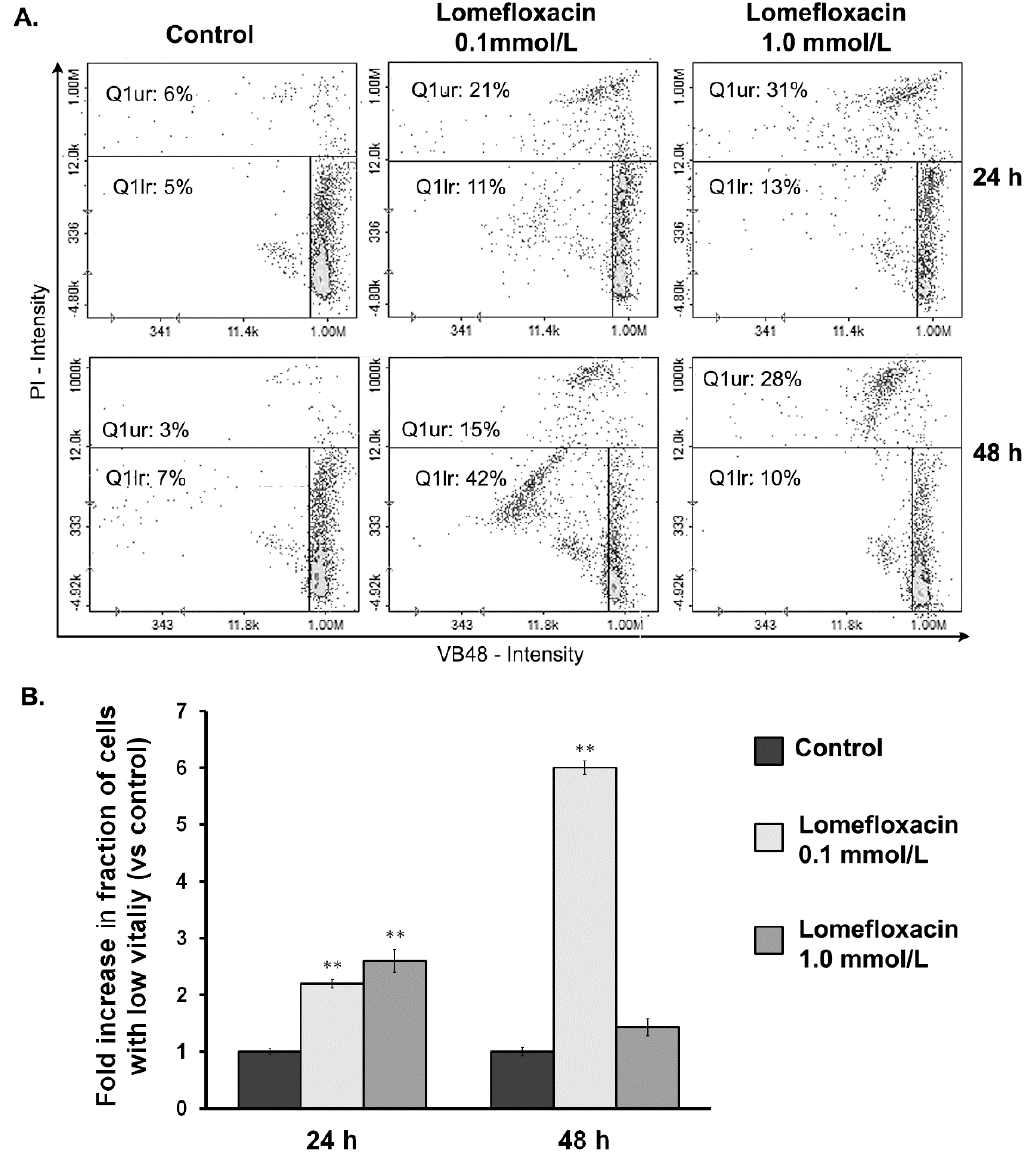
Figure 4. Analysis of the cellular Cellular Reduced Glutathione (GSH) levels in COLO829 cells after exposure to lomefloxacin treatment. ( A ) Histograms presenting the changes of GSH levels in cells exposed to lomefloxacin in concentrations of 0.1 and 1.0 mmol/L. The presented histograms are representative of three independent experiments with similar results. Q1ur are dead cells; Q1lr are cells with low GSH levels (with low vitality). ( B ) The effect of lomefloxacin on cellular GSH levels in COLO829 cells. The cells were treated with lomefloxacin in concentrations of 0.1 and 1.0 mmol/L for 24 and 48 h. Mean values ± SEM from three independent experiments ( n = 3) performed in triplicate are presented. ** p < 0.005 versus control samples.